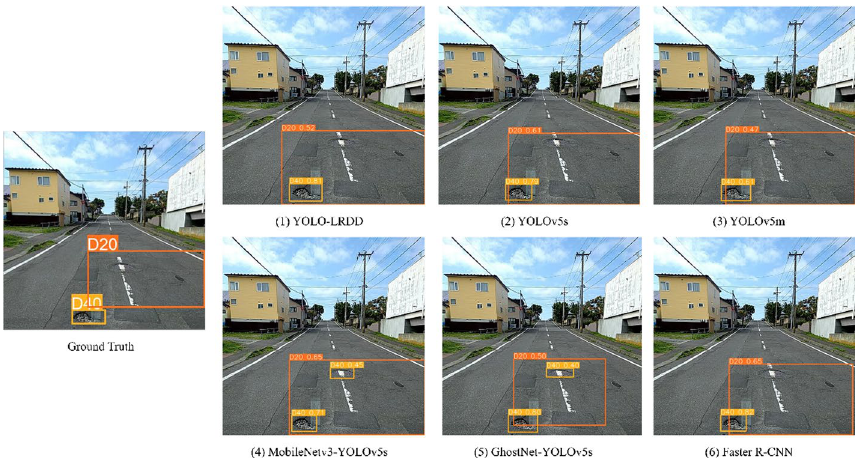
Fig. 10 Comparison of the detection of alligators and potholes under strong